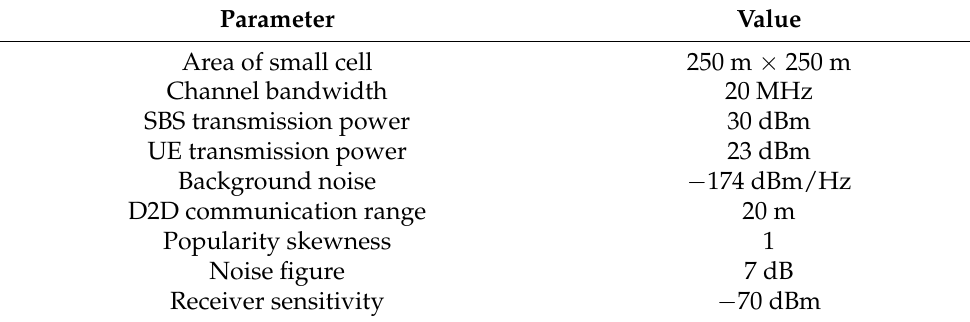
Table 3. System parameters.